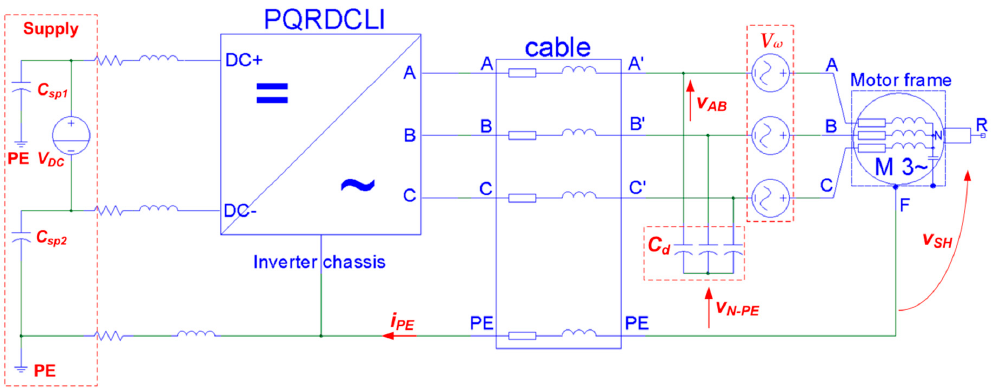
Figure 12. Simulation model of AC drive system with PQRDCLI.